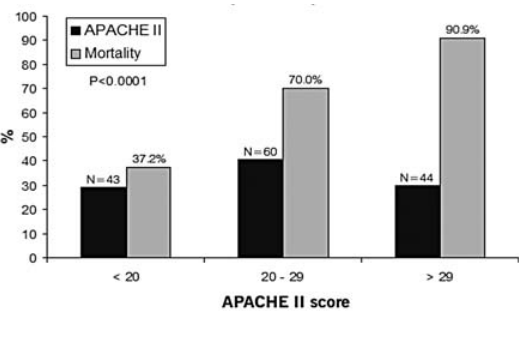
Figure 2 Mortality associated with APACHe II scores in patients with acute kidney injury admitted to an infectious diseases ICU. dark bars represent the percentage of patients with an APACHe II in the indicated range and light bars represent the percentage of mortality in each group of patients.